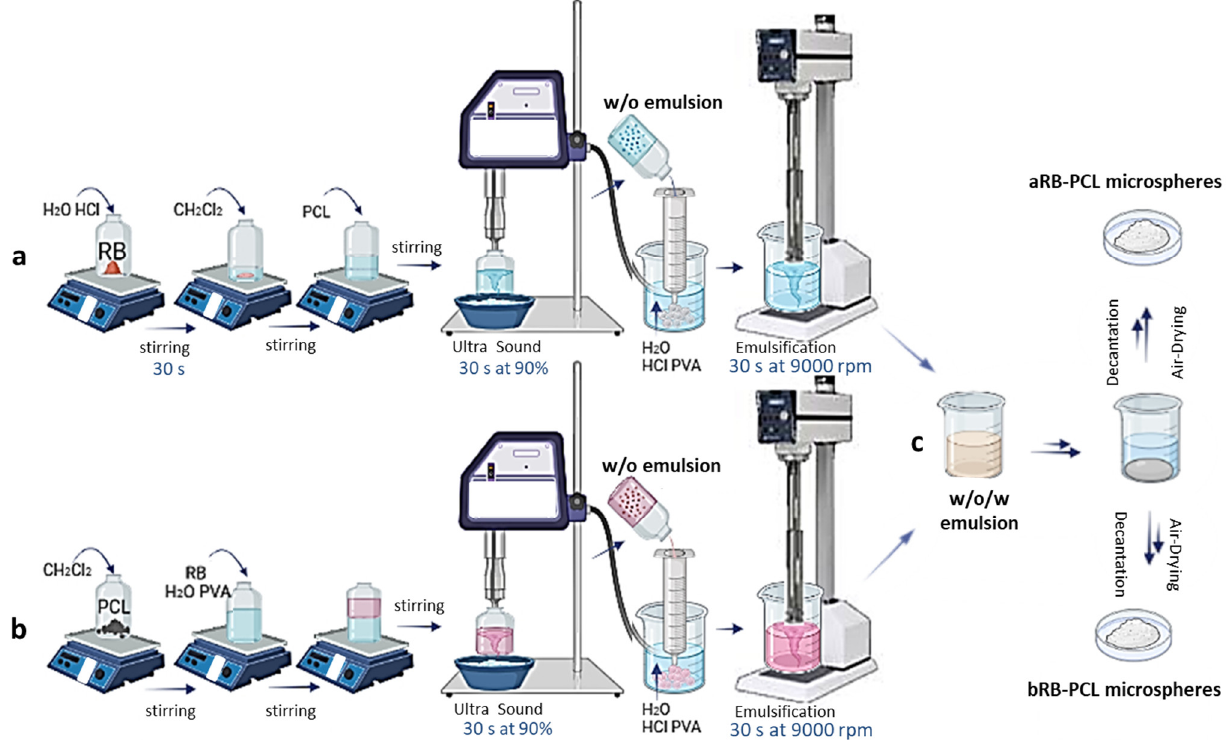
Figure 2. Schematic preparation of RB-PCL microspheres: ( a ) first part of aRB-PCL preparation; ( b ) first part of bRB-PCL preparation; ( c ) the last part of the process is in common, even carried out separately, resulting in aRB-PCL and bRB-PCL, respectively.